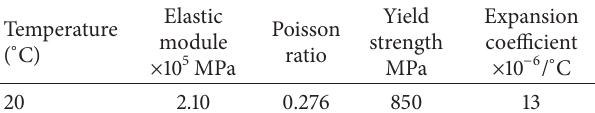
Table 1: Impeller material properties (density: 7850 kg/m 3